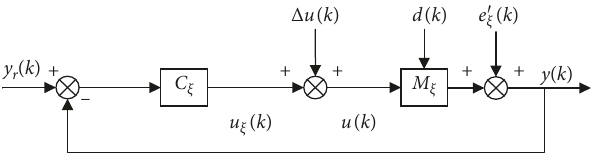
Figure 2: VES of the WMNNAC system.